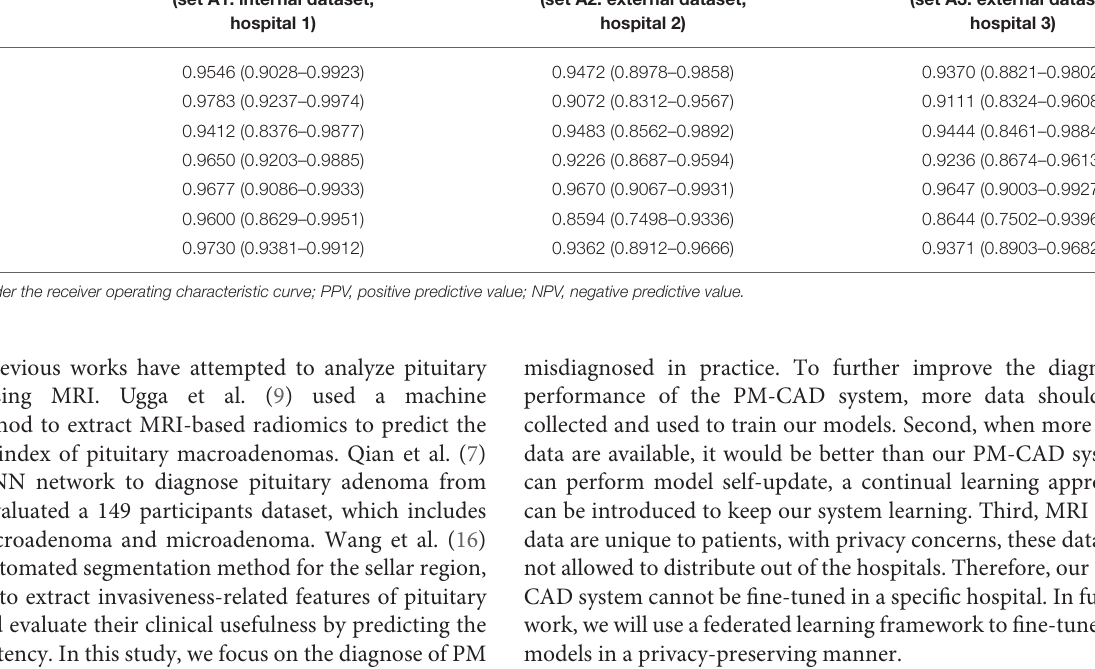
TABLE 2 | The diagnosis performance of the PM-CAD system in the validation set A (internal and external datasets). Evaluation